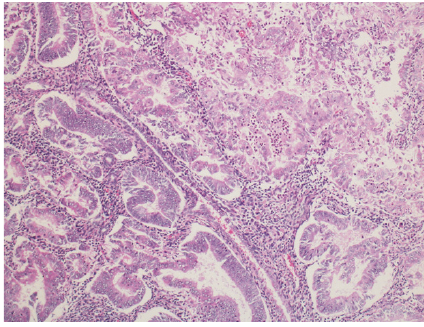
Figure 4: Histopathological examination showing poorly differen- tiated squamous cell carcinoma of the cervix (H&E